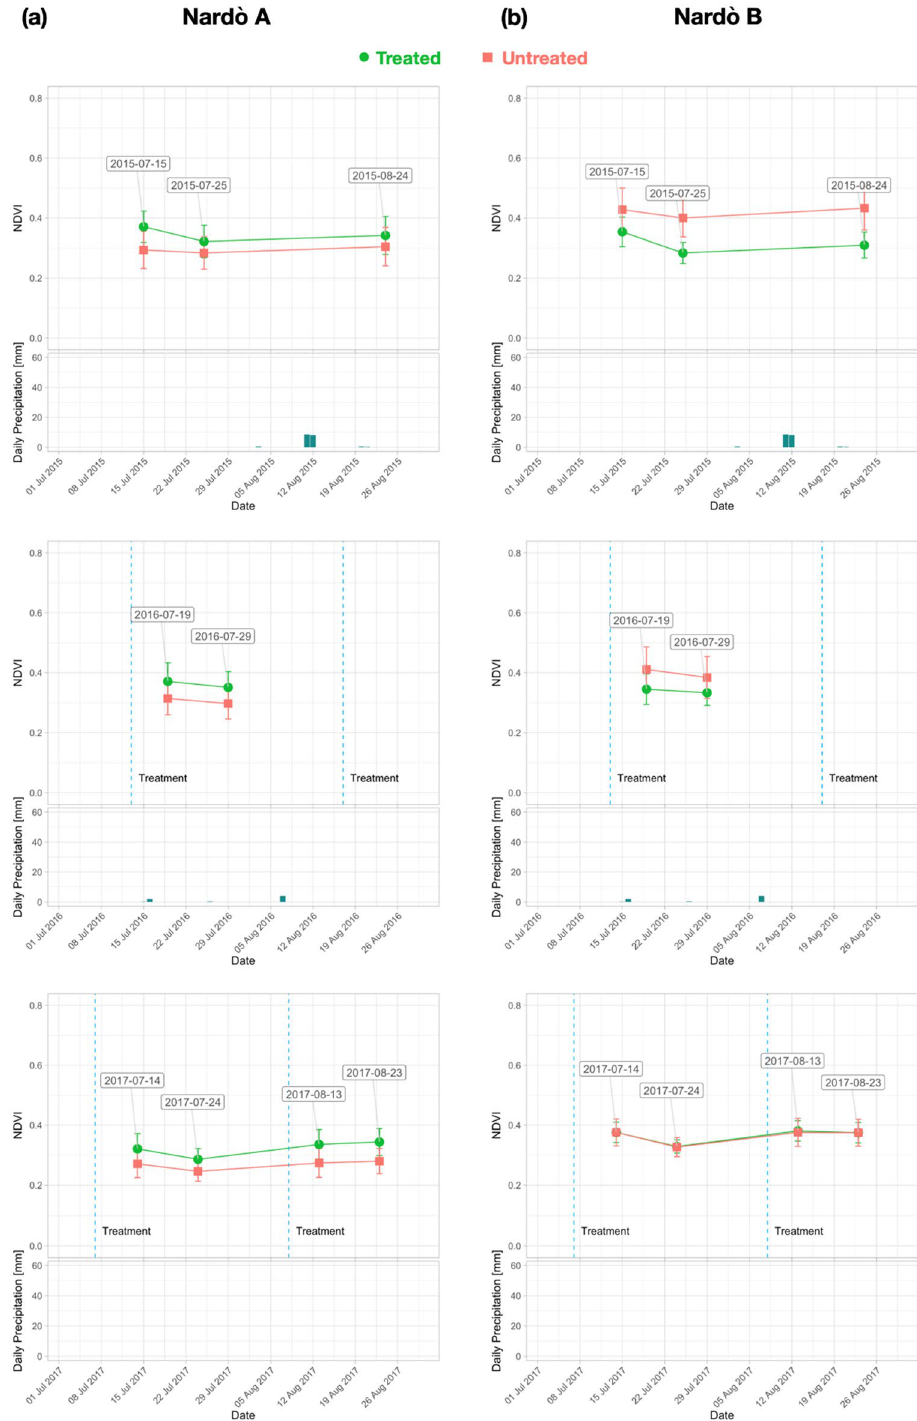
Figure 8. NDVI trend for each year (2015–2017) from S-2 date: ( a ) Nardò A; ( b ) Nardò